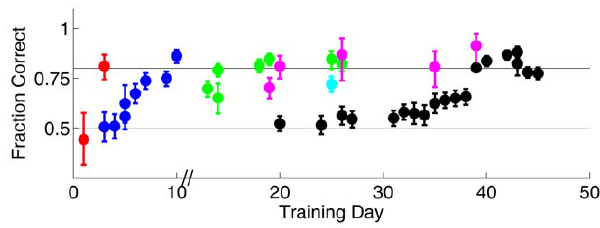
Figure 2. Training on multiple visual tasks: subject S1. Each symbol shows the fraction of correct responses for one task at the end of one day. Color indicates task as follows: Approach Salient Visual Target (Figure 1A) with statue target (red) or CW grating target (magenta); Image Discrimination (Figure 1B) (blue); Motion Discrimina- tion (Figure 1C) with 85% coherent motion (green); and Orientation Discrimination (Figure 1D). Error bars indicate the 95% binomial confidence bounds. Training day indicates calendar days, except that a three week gap in training occurred after day 10 (slash marks). Performance is only reported when the rat’s side bias was , 15% and # 40 valid trials completed on a given day; training occurred on other days and tasks not meeting these criteria.